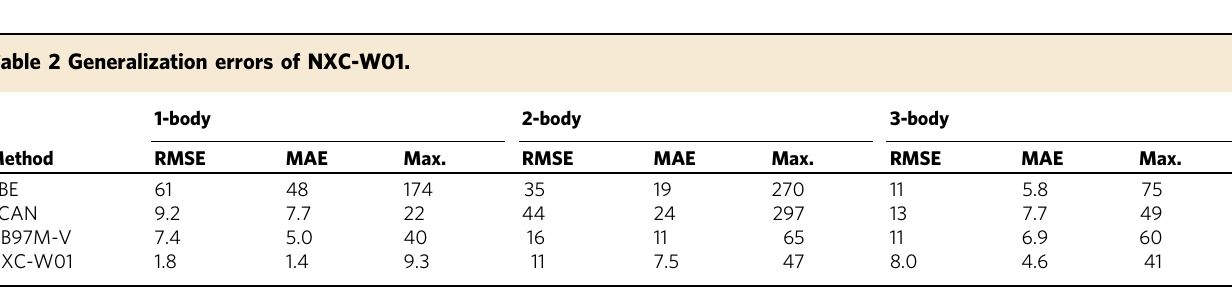
Table 2 Generalization errors of